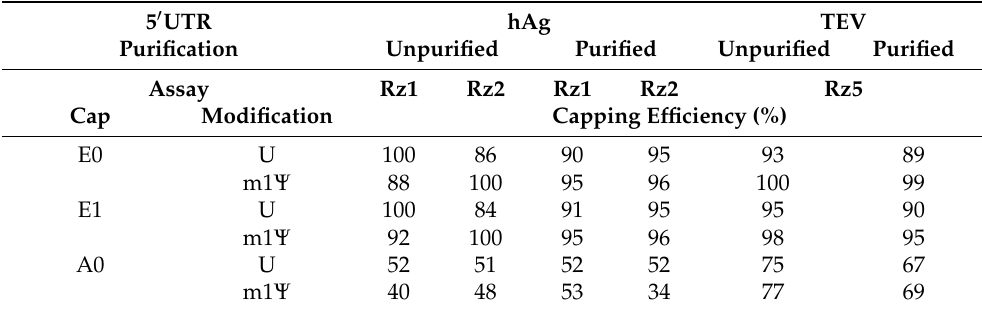
Table 3. Capping efficiencies of IVT mRNAs quantified after ribozyme-mediated cleavage assays and visualized using 21% PAGE, 8 M urea on Figure